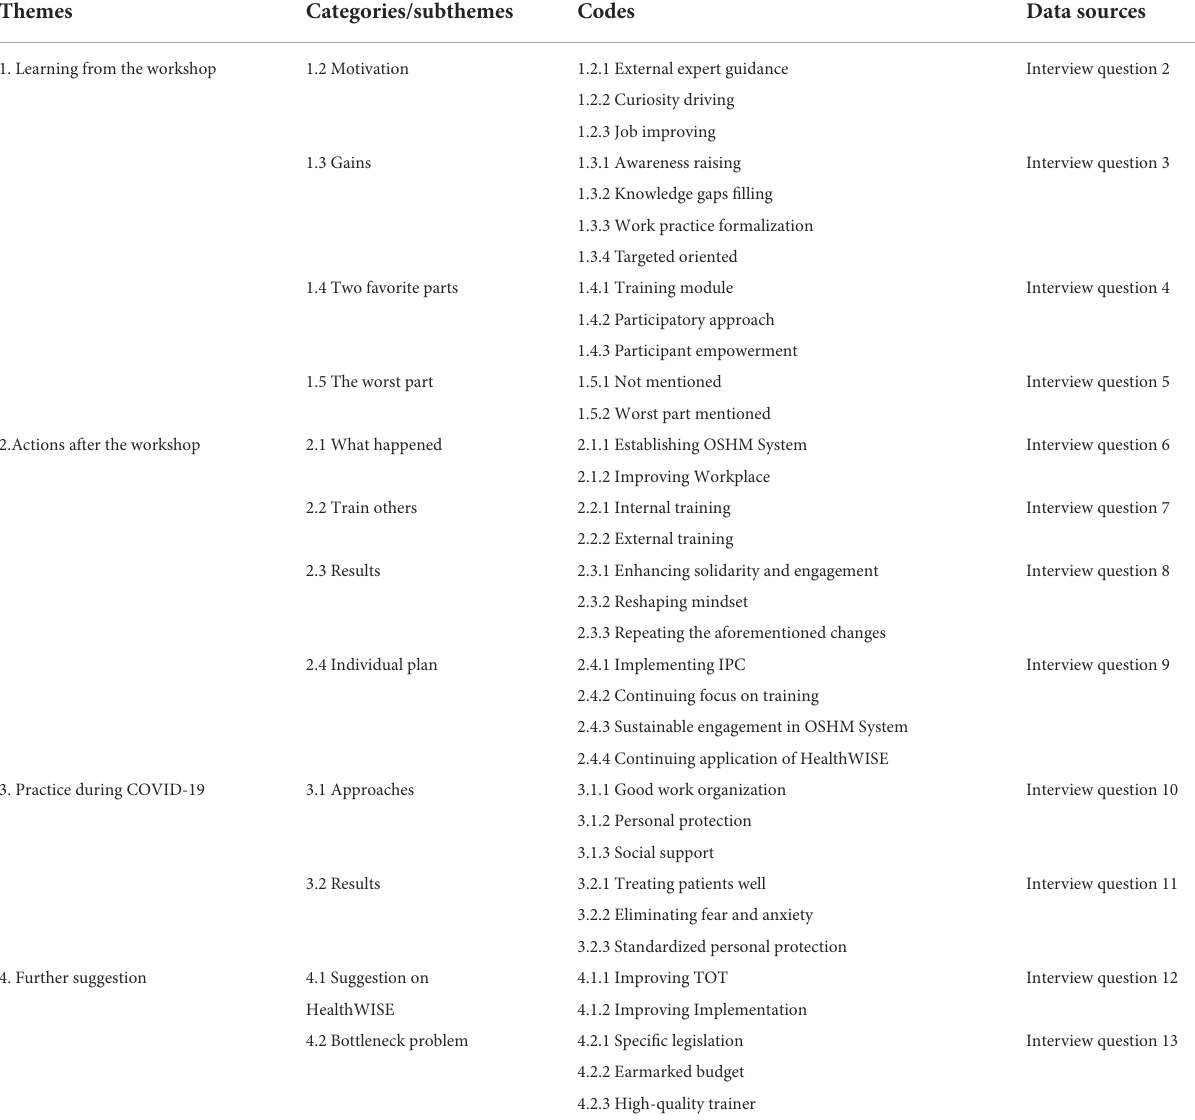
TABLE 2 Codebook for interview analysis among participants of HealthWISE TOT